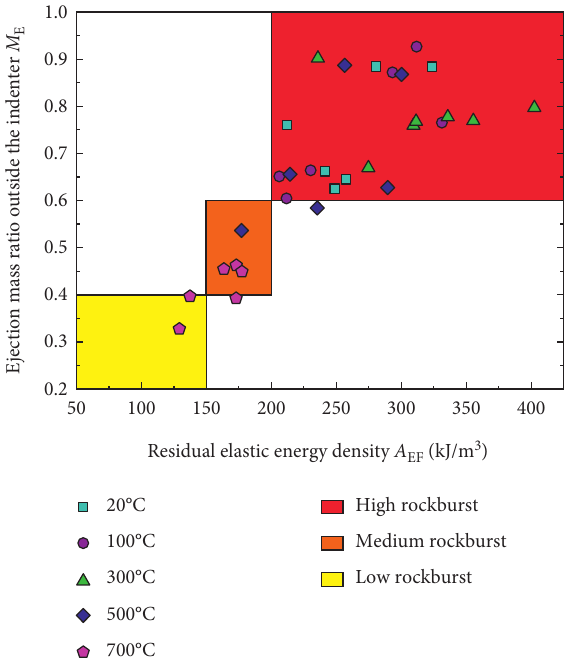
Figure 8: Relationship between M